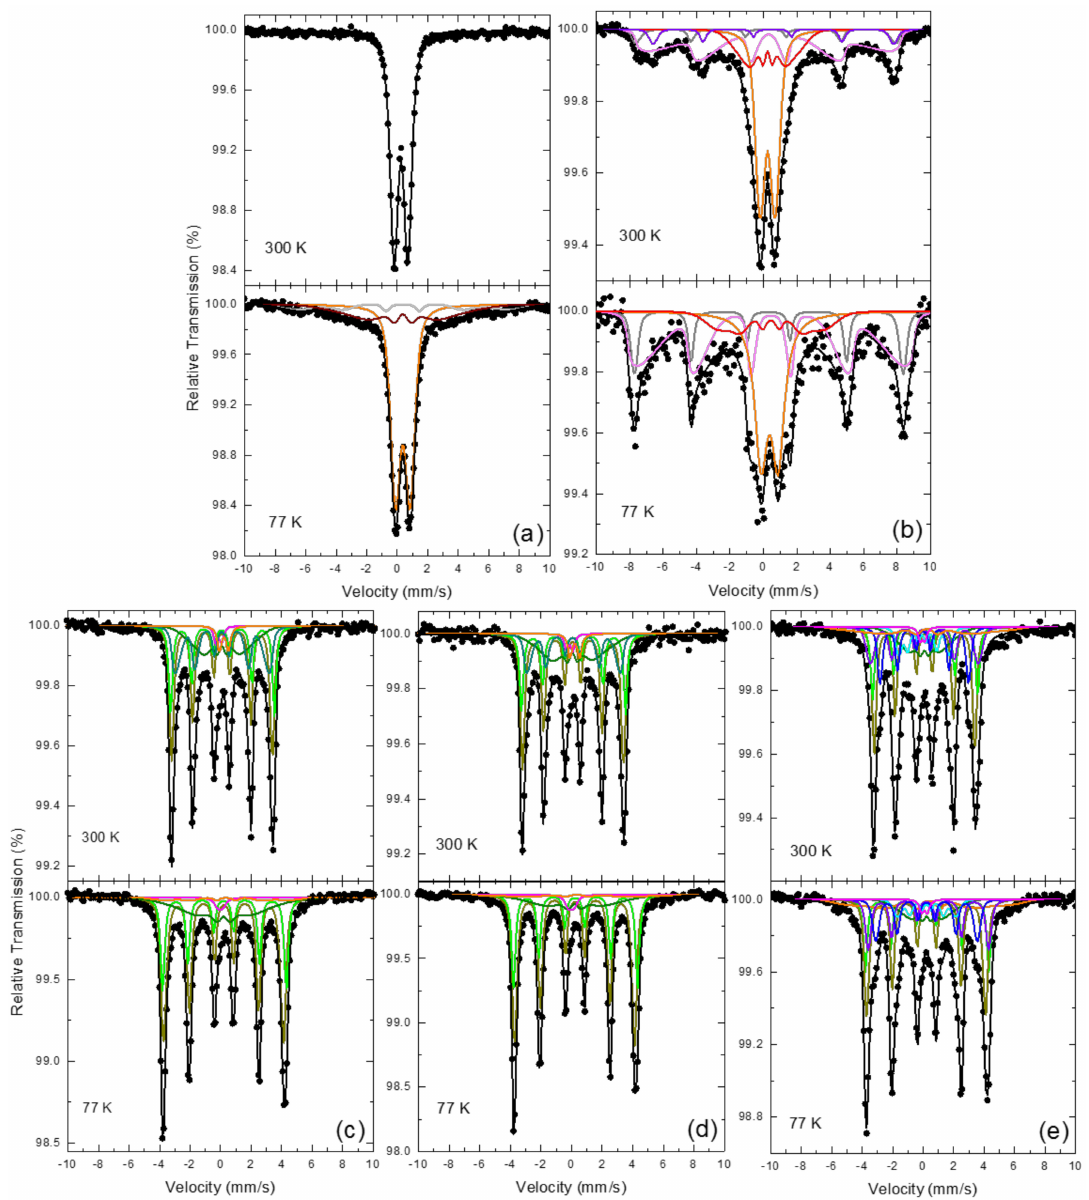
Figure 7. 57 Fe Mössbauer spectra of the CP ( a ); NHD-600 ( b ); NHD-750 ( c ); NHD-900 ( d ) and NHD-1050 ( e ) samples collected at 300 and 77